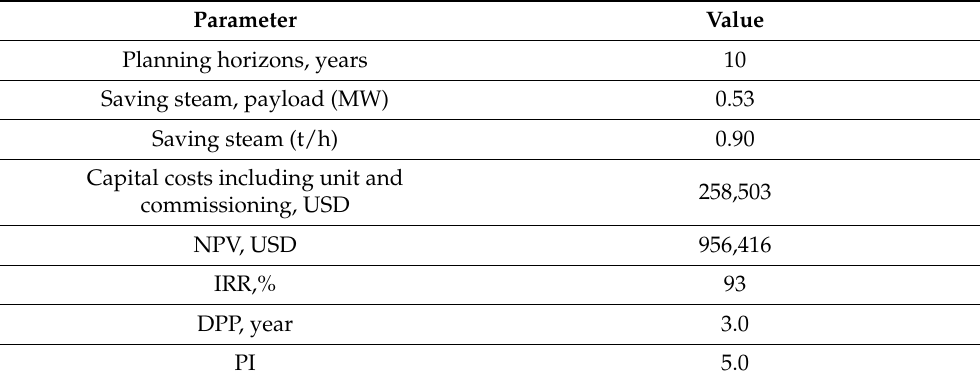
Table 2. Economic assessment of the retrofit project